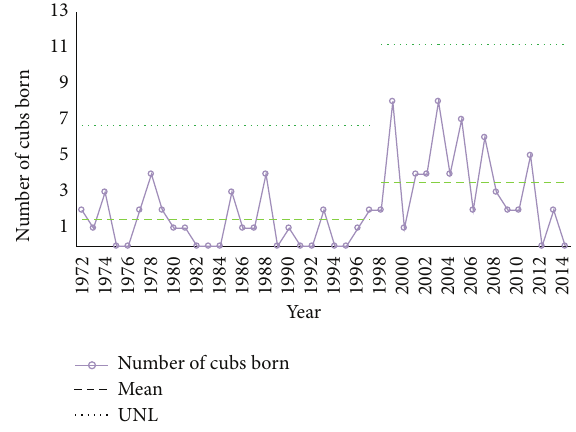
Figure 5: Changes in breeding output of the captive zoo population of Moroccan Royal Lions (data from